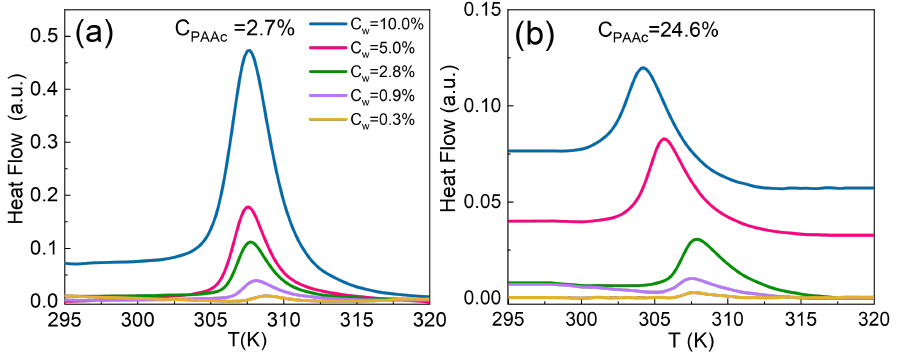
Figure 4. DSC thermograms for IPN microgels ( a ) at C PAAc = 2.7% and ( b ) C PAAc = 24.6%, pH 5.5, at different concentrations and fixed heating rate